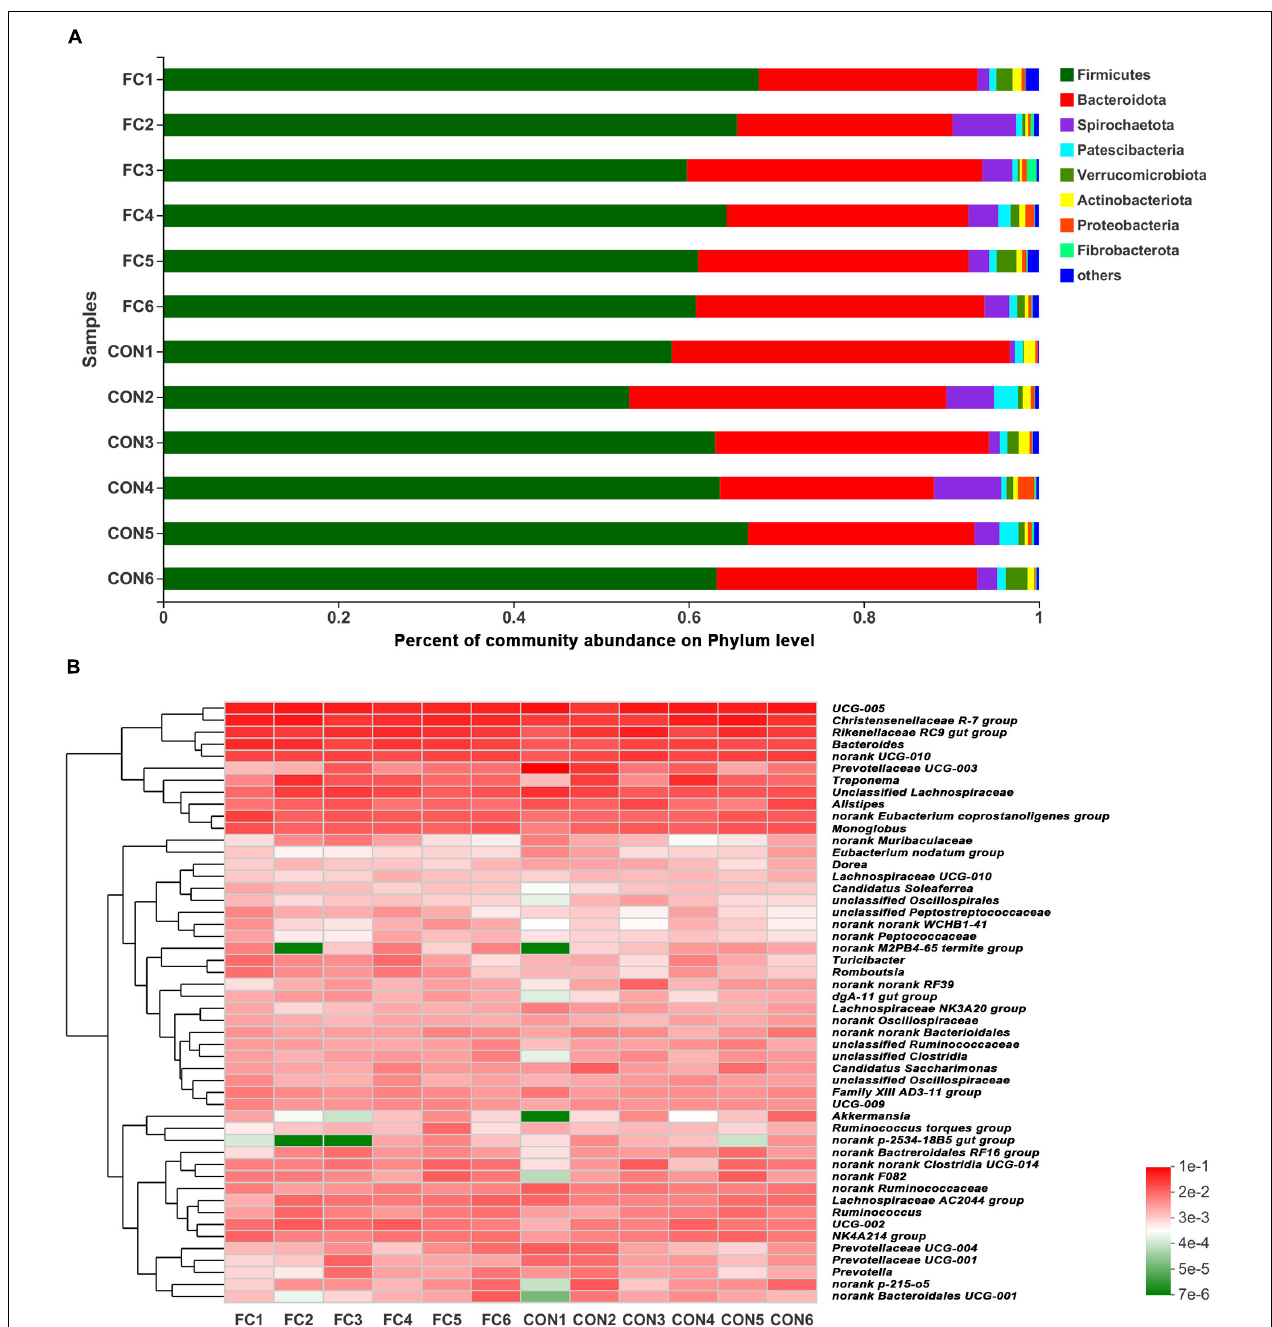
FIGURE 3 | Phylum-level and genus-level fecal microbiota profiles in follicular cyst ewes and normal follicle ewes. (A) Stacked column chart showing the relative phylum-level bacterial abundance ( > 1%) per fecal sample. (B) The heatmap shows the relative genera-level bacterial abundance. FC represents ewes with follicular cysts and CON represents ewes with normal follicle. Numbers represent individual